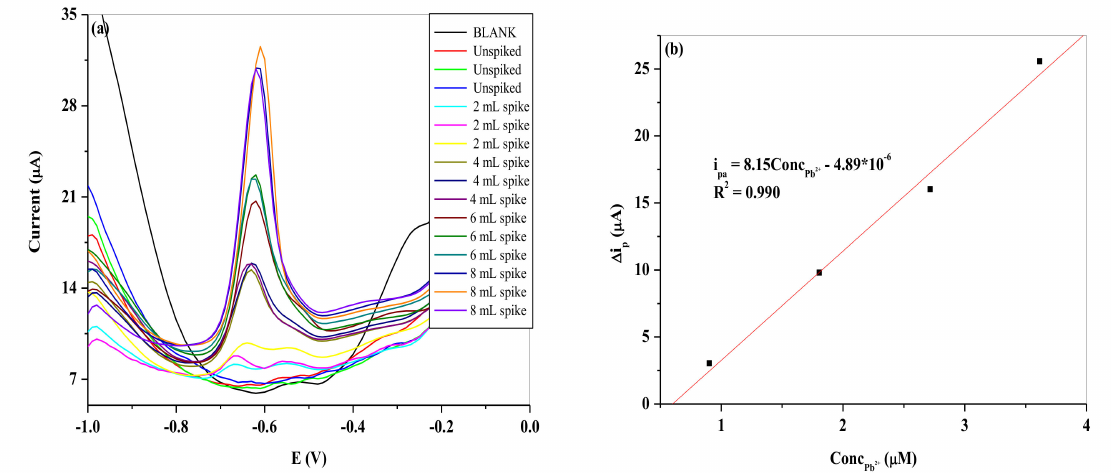
Figure 19. Represent ( a ) the SWV of the different spikes with Pb 2+ concentration and ( b ) the resultant calibration curve at SPCE/OPE/BiONPs/PANI at optimum conditions. (Potential vs. Ag/AgCl).